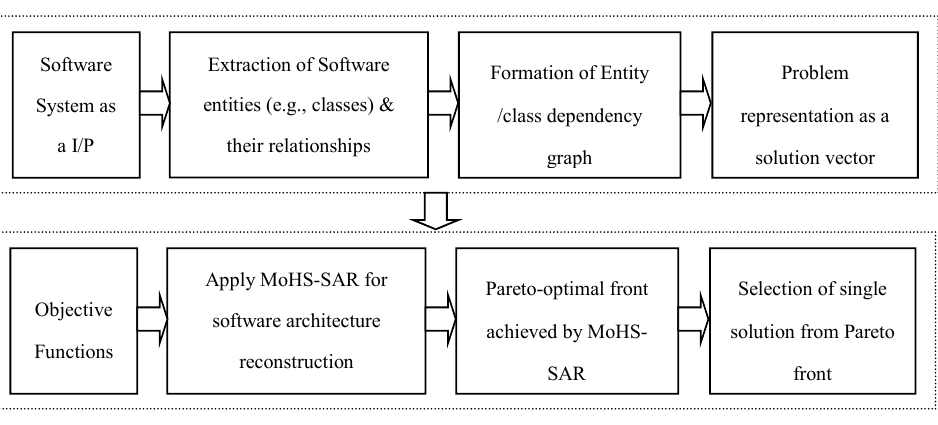
Figure 1. General Framework of the proposed software architecture reconstruction.